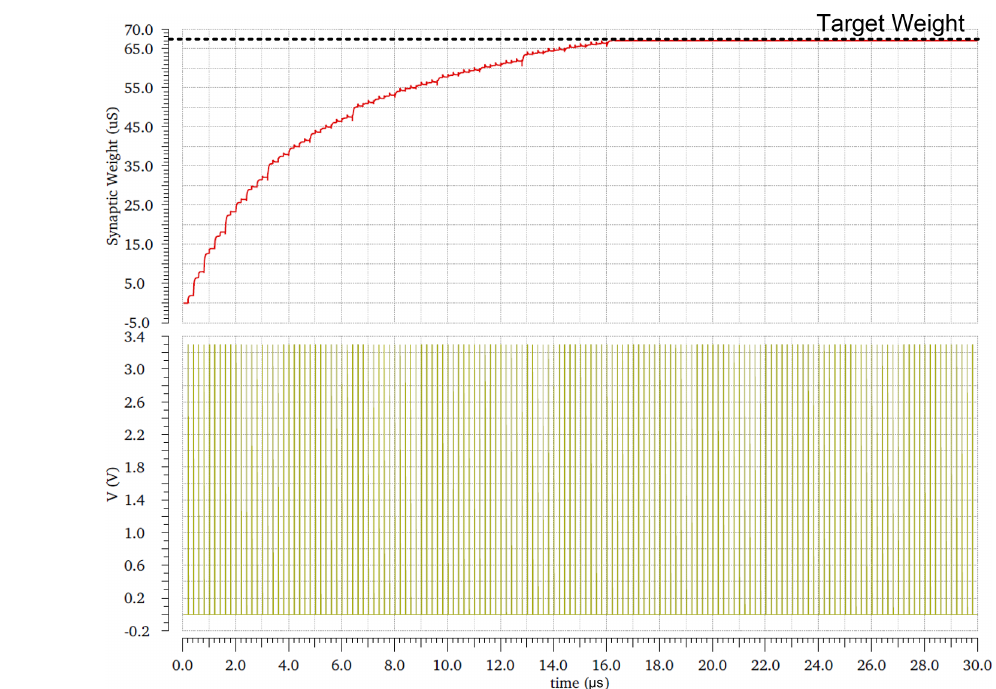
Figure 33. Target weight at V LEAK equal to 1V, vg1 and vg2 equal to 1V, and V RFR equal to 800mV. Circuit conditions are V dd of 3 . 3V, and temperature equals 27 ◦ C and on the nominal process.